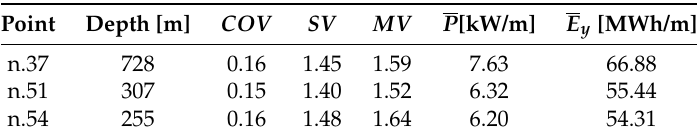
Table 3. Statistical energy parameters at each reference point; COV is the Coefficient of Variation, SV is the Seasonality Variability index, MV is the Monthly Variability index, P the mean wave energy flux, and E y the total wave energy in the average